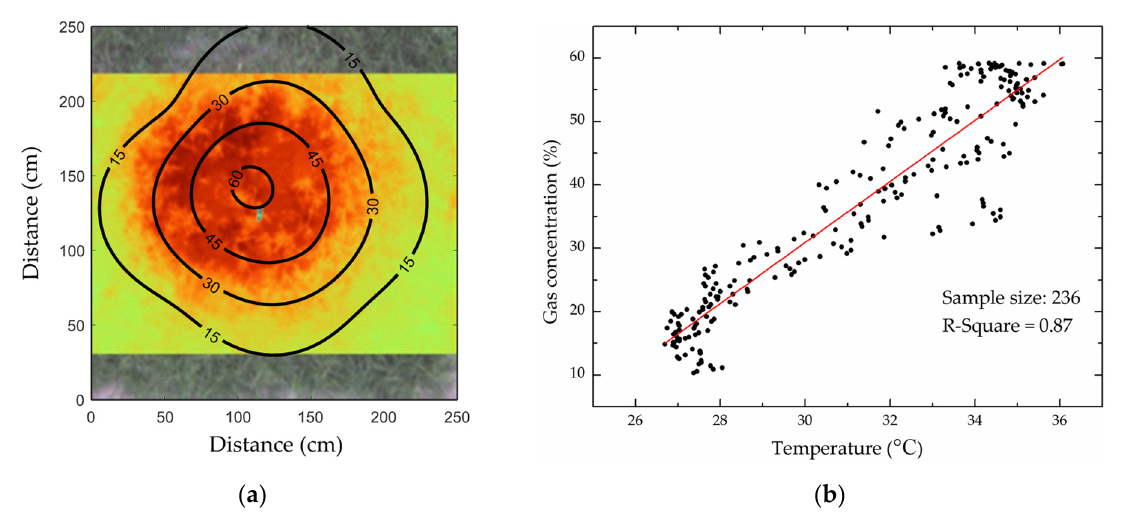
Figure 7. ( a ) Spatial relationship between methane concentration in soil and stressed vegetation areas. ( b ) Correlation analysis results of methane concentration and canopy temperature.